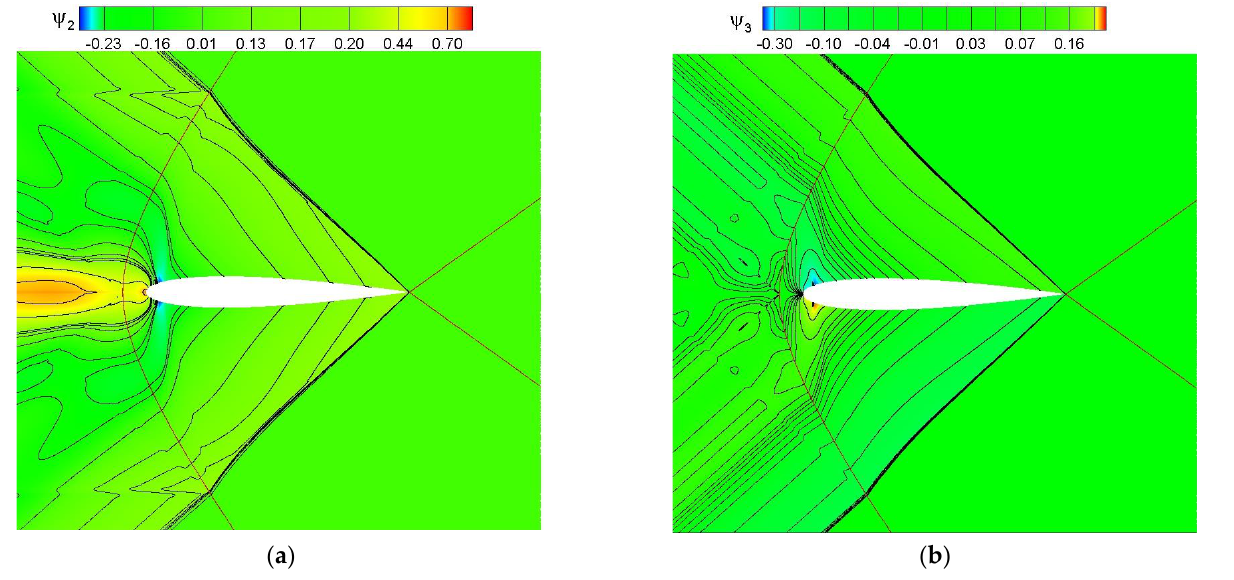
Figure 6. Flow past a NACA0012 airfoil at M = 1.5 and α = 0°. Contour lines for the adjoint x − momentum variable ψ 2 ( a ) and y − momentum variable ψ 3 ( b ). The bow and fish-tail shocks are indicated for reference.